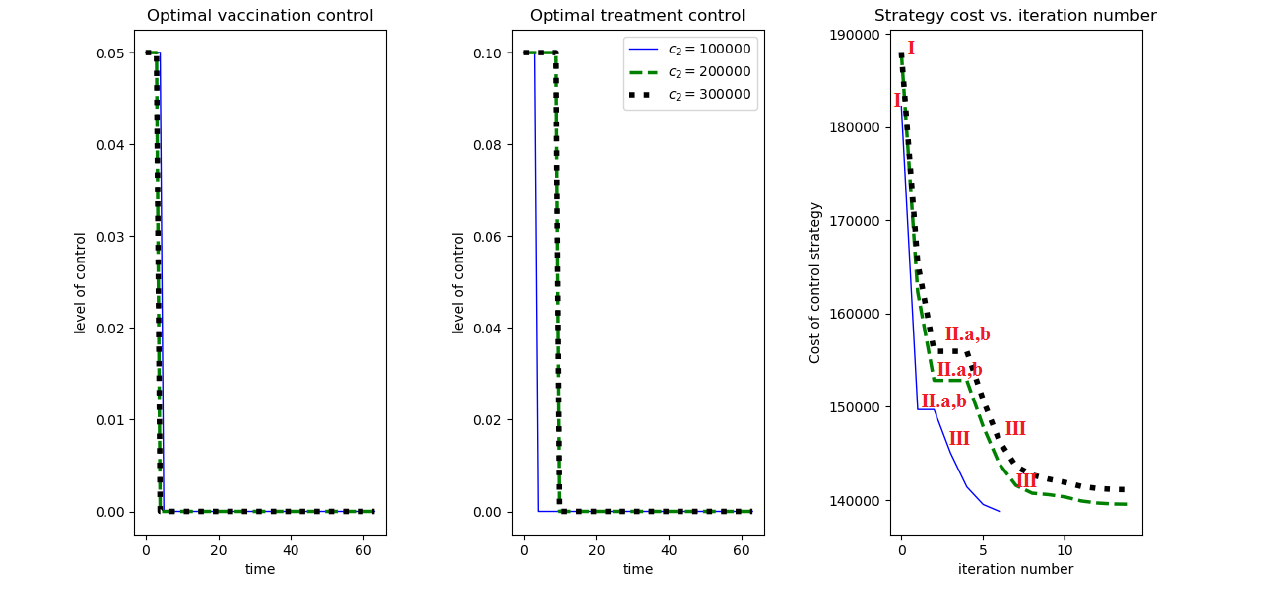
Figure 10. Optimal vaccination, treatment controls and strategy cost for different values of c 2 .